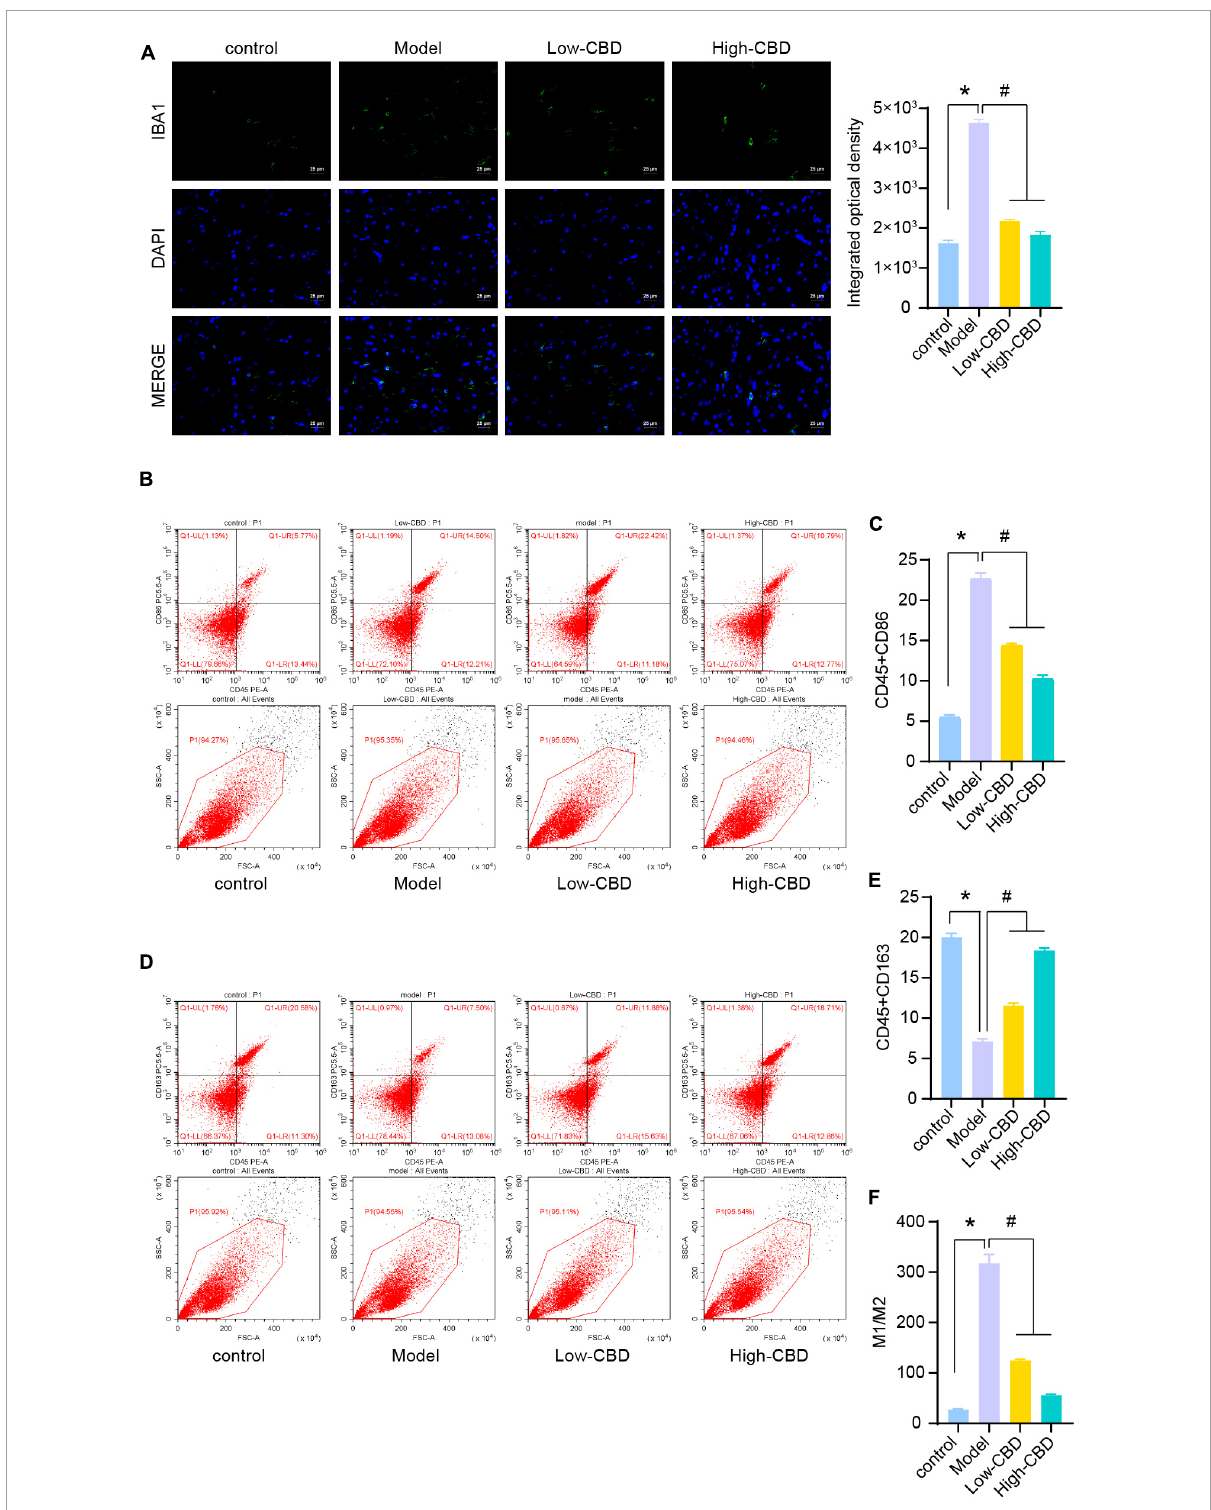
FIGURE2 Effects of cannabidiol (CBD) on microglia polarization in epileptic rats. (A) IBA1 expression was detected by immunofluorescence (IF). (B,C) Analysis of M1 type microglia. CD45 + CD86 + double positive cells are expressed as M1 type microglia. (D,E) Analysis of M2 type microglia. CD45 + CD163 + double positive cells are expressed as M2 type microglia. (F) Statistical graph of M1/M2. *Represents significant comparison with the control group, and #represents significant comparison with the Model group, P <